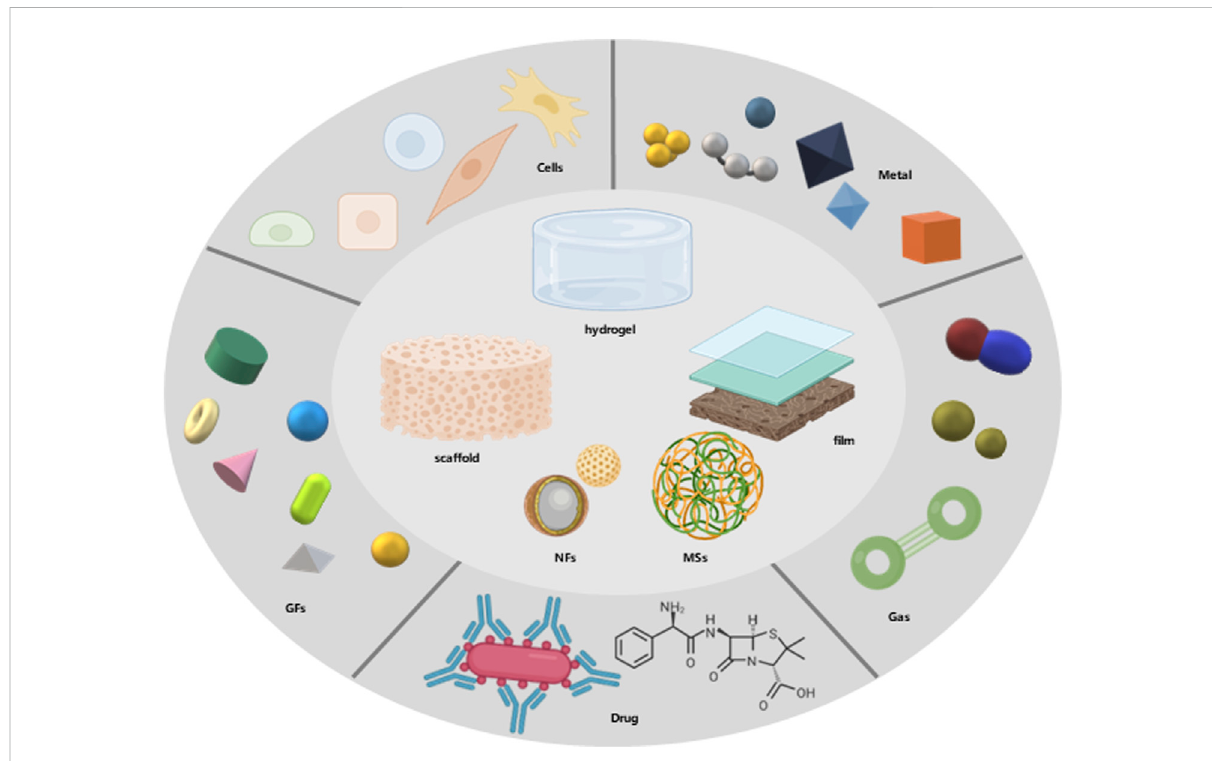
FIGURE 3 The combination of composite biodegradable